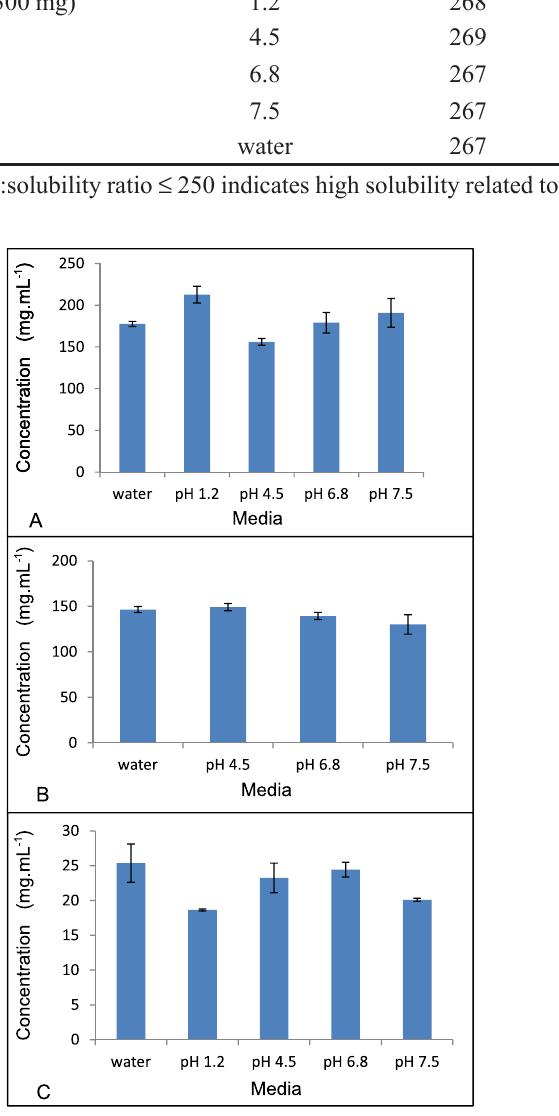
FIGURE 1 - Average solubility of 3TC (A), d4T (B) and AZT (C) in water, pH 1.2 (except d4T), pH 4.5, pH 6.8 and pH